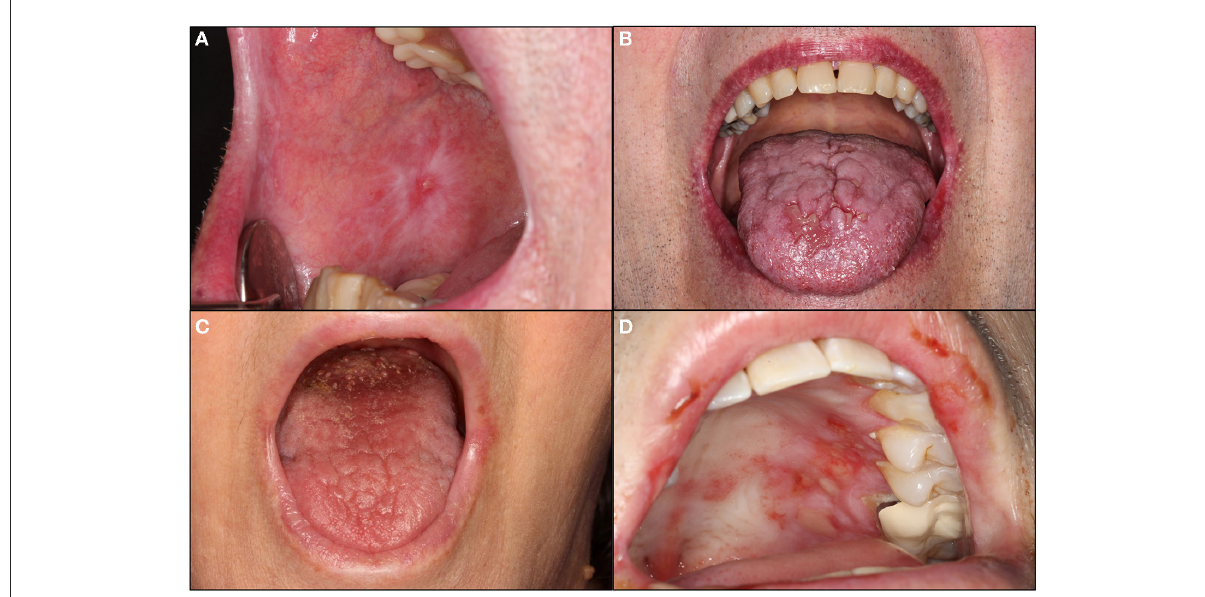
FIGURE2 Oral mucosal and salivary immune related adverse events (irAEs). (A,B) demonstrate oral lichen planus-like irAEs characterized by white striations of the right buccal mucosa with a central pinpoint ulceration and surrounding erythema (A) and generalized erythema of the upper and lower lip vermilion with atrophy, white changes, and coalescing ulceration of the midline anterior dorsal tongue with surrounding erythema (HSV-negative; B ). (C) demonstrates a Sjögren syndrome-like irAE with desiccated oral mucosa and loss of filiform papillae of the dorsal tongue. (D) demonstrates a mucous membrane pemphigoid irAE characterized by scattered ulcerations of the hard palatal mucosa and upper lip mucosa with significant surrounding erythema